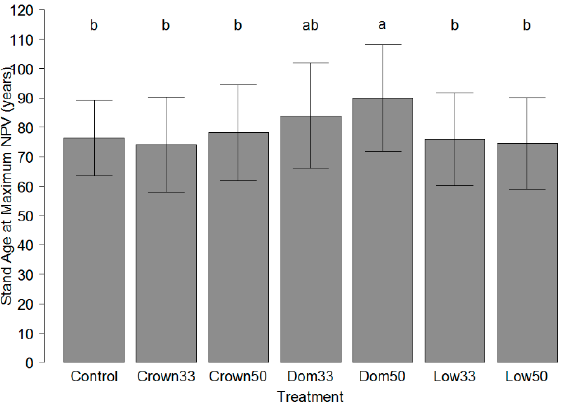
Figure 4. Stand age at time of maximum net present value (NPV) for all treatments and control including error bars (one standard deviation). Letters above the bars indicate statistically significant differences between treatments and control.